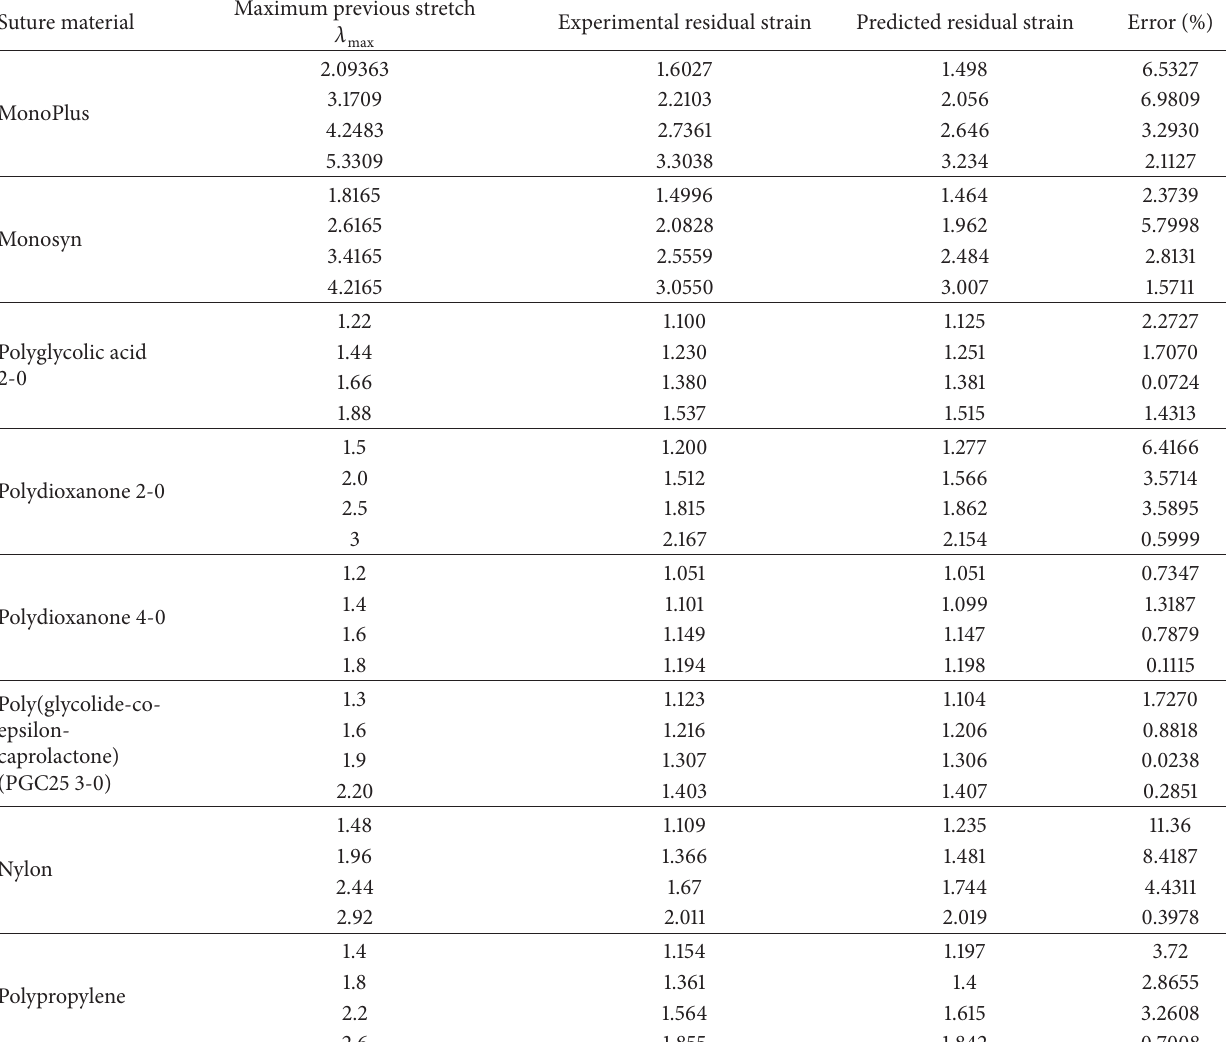
Table 1: Comparison between experimental and predicted residual strain deformations of the selected suture